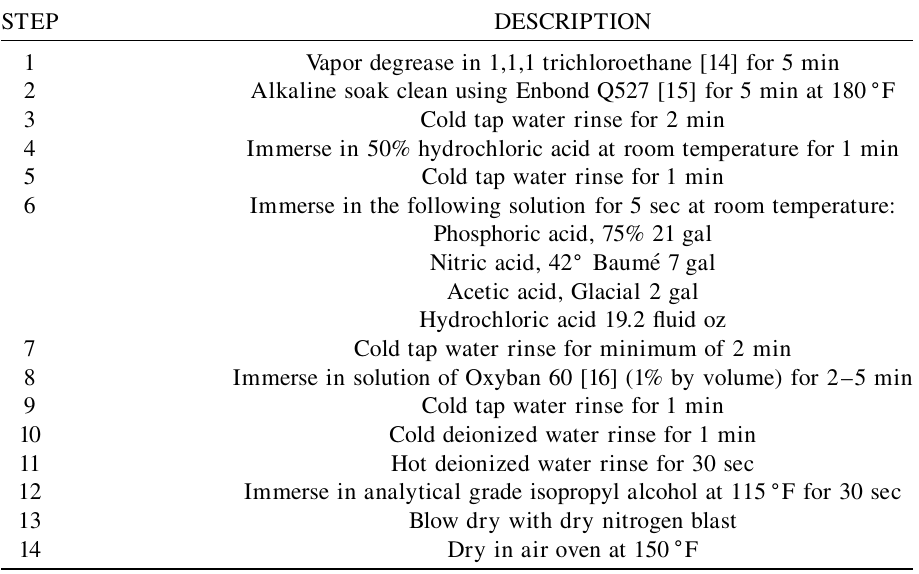
TABLE V. Procedure for vacuum cleaning of end cap surface.